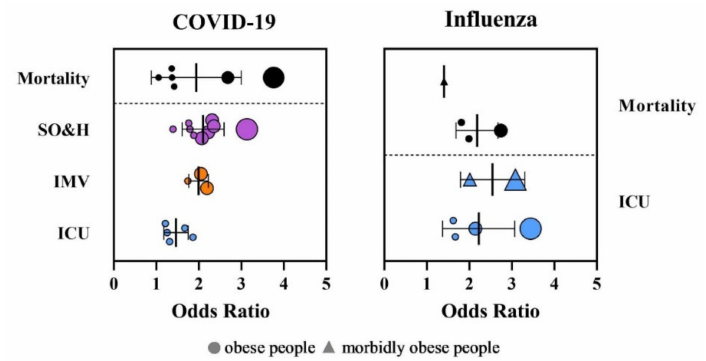
Figure 2. Distribution of odds ratios (OR) for intensive care unit administration (ICU), invasive mechanical ventilation (IMV), severe outcome and hospitalization (SO&H), and mortality in patients with obesity after infection with SARS-CoV-2 and influenza virus. The size of the dots corresponds to number of analyzed